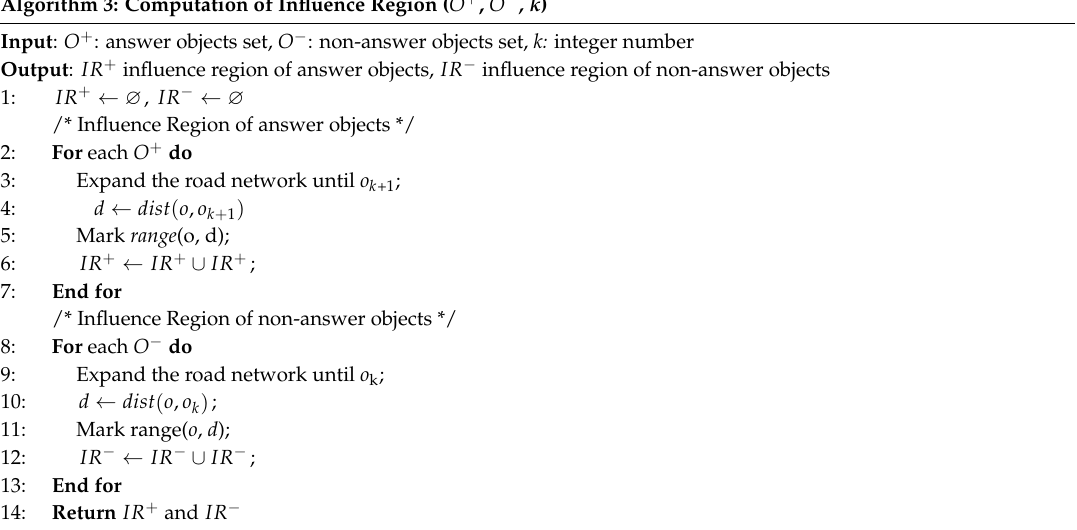
Algorithm 3: Computation of Influence Region ( (cid:2171) (cid:2878) , (cid:2171) (cid:2879) , k ) Input : (cid:1841) (cid:2878) : answer objects set, (cid:1841) (cid:2879) : non-answer objects set, k: integer number